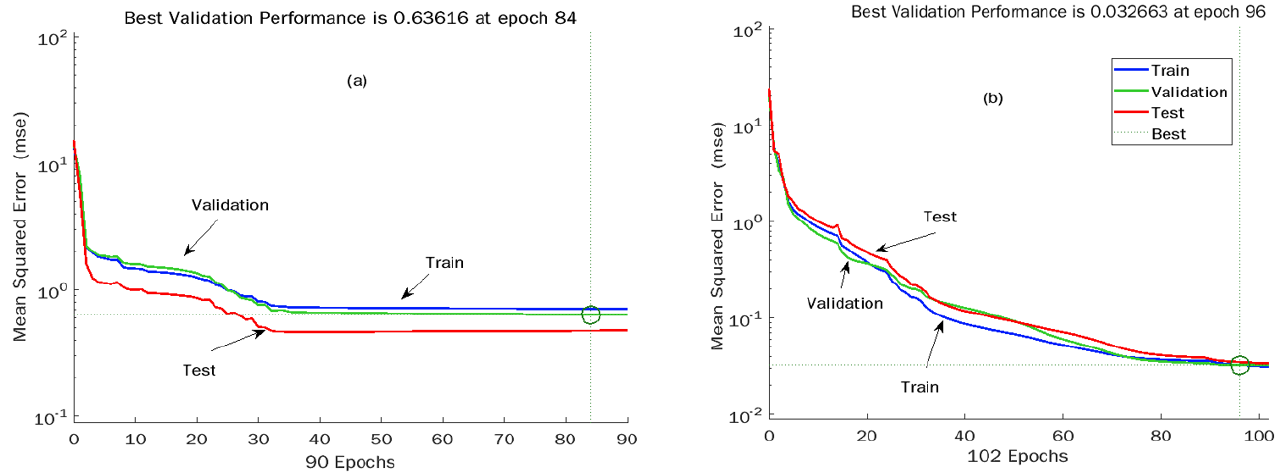
Figure 9. MSE versus Epoch plot for J nr 3.2 of ( a ) Unaged and ( b ) RTFO